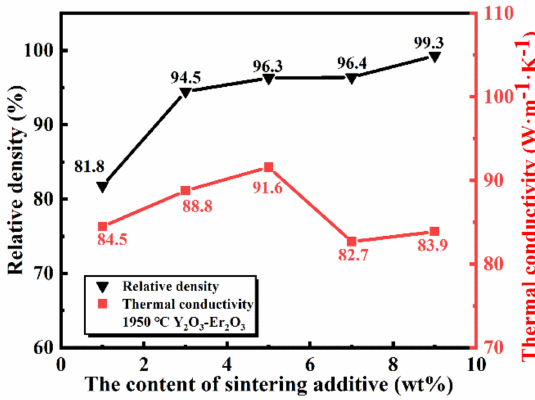
Figure 9. Relative density and thermal conductivity of the sintered SiC samples at 1950 ◦ C as a function of the sintering additives